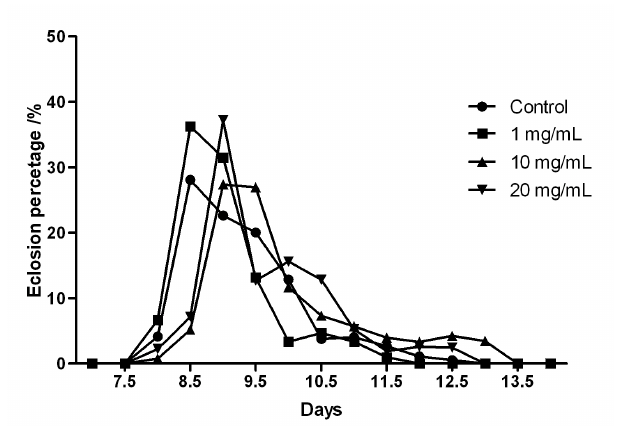
Figure 6. Effect of theanine on Drosophila